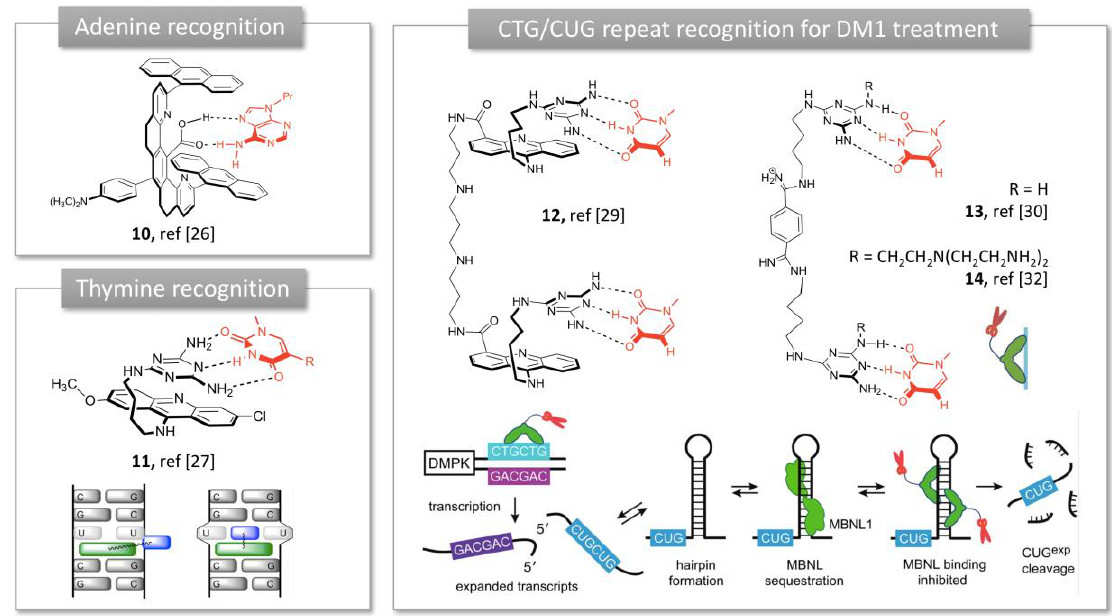
Figure 3. Receptors developed by Zimmerman: from molecular tweezers to triaminotriazine ligands for trinucleotide repeat recognition and cleavage. Adapted from [15].